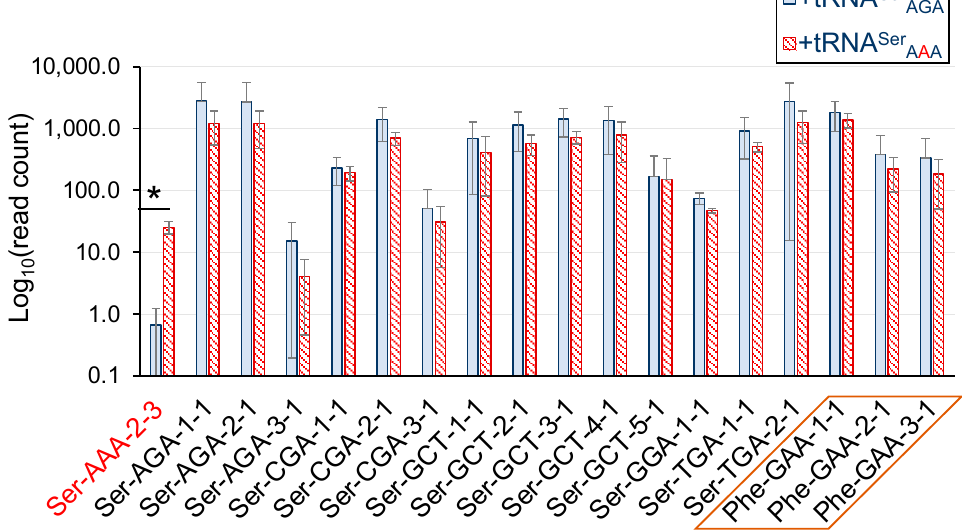
Figure 2. Quantitation of tRNA levels in N2a cells expressing wild-type or mistranslating tRNAs. In N2a cells transfected with a plasmid bearing wild-type tRNA Ser AGA (blue bars) or the mistranslating tRNA Ser AAA variant (red hashed bars), the abundance of all tRNA transcripts was quantified using the Hydra-seq method of tRNA sequencing (see Supplementary Information, Figures S1 and S2). The abundance of tRNA Ser and tRNA Phe isoacceptors was plotted as the Log 10 of read counts. As anticipated, there is a significant abundance of tRNA SerAAA detected only in cells expressing the mis- translating tRNAs. On average, we observed less than 1 read count on average for tRNA SerAAA in cells transfected with a plasmid expressing wild-type tRNA Ser , while in cells transfected with a plas- mid expressing the mistranslating tRNA, we observed ~26 read counts on average for tRNA SerAAA . The abundance of other Ser-decoding tRNAs or Phe-decoding tRNAs (orange box) was not changed significantly in mistranslating cells. Error bars represent the mean ± 1 standard deviation of three biological replicates. Significant differences from pairwise independent sample t-tests are indicated (* p < 0.05); all other pairwise comparisons between wild-type and mistranslating cells were not significant.